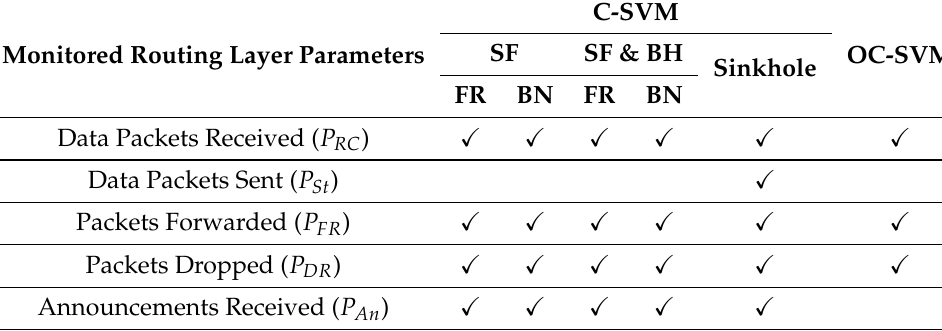
Monitored Routing Layer